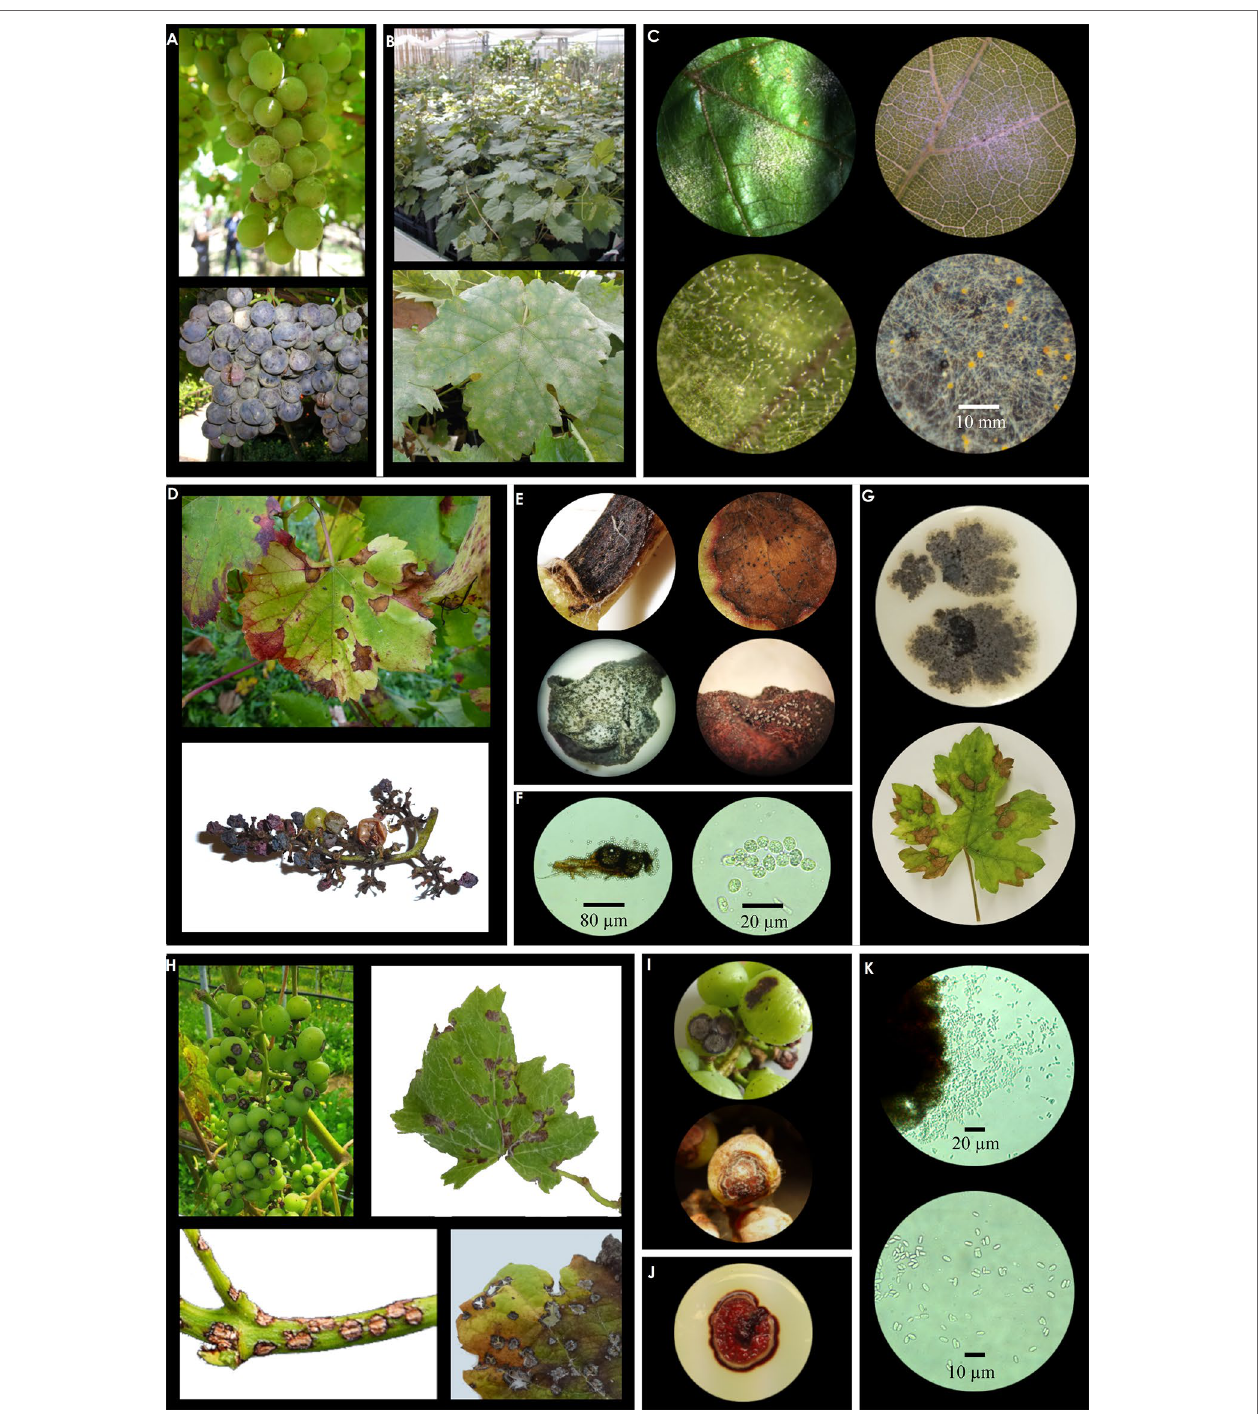
FIGURE 3 | Fungal morphological characteristics and symptoms of powdery mildew (PM, panel A - C ), black rot (BR, panel D - G ), and anthracnose (AN, panel H - K ). (A) PM on grapes (field). (B) PM on leaves (greenhouse). (C) PM leaf disc infection under different magnification (above); conidiophores and conidia on a leaf surface (below-left); mature (black) and immature (yellow) chasmothecia (below-right). (D) BR field symptoms on leaves and grape cluster. (E) G. bidwellii pycnidia on petiole and leaf (above), on berry with detail of cirri development under humid conditions (below). (F) Detail of G. bidwellii pycnidia and conidia under different magnification. (G) G. bidwellii isolate growing on culture media (above) and leaf symptoms after artificial infection (below). (H) AN field symptoms on a grape cluster, leaf and young shoot, along with detail about the typical “shot-hole” lesions on old infected leaf. (I) AN symptom details on berries. (J) E. ampelina colony on culture media. (K) E. ampelina acervulus releasing conidia and detail of